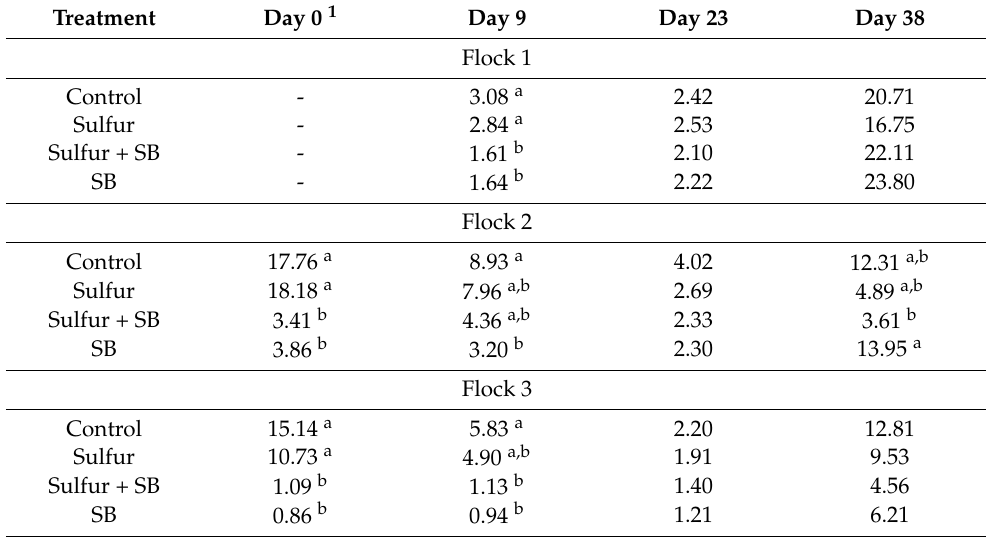
Table 3. Ammonia levels (ppm) measured on days 0, 9, 23, and 38 in litter from broilers treated with feed-through sulfur and sodium bisulfate litter amendment.